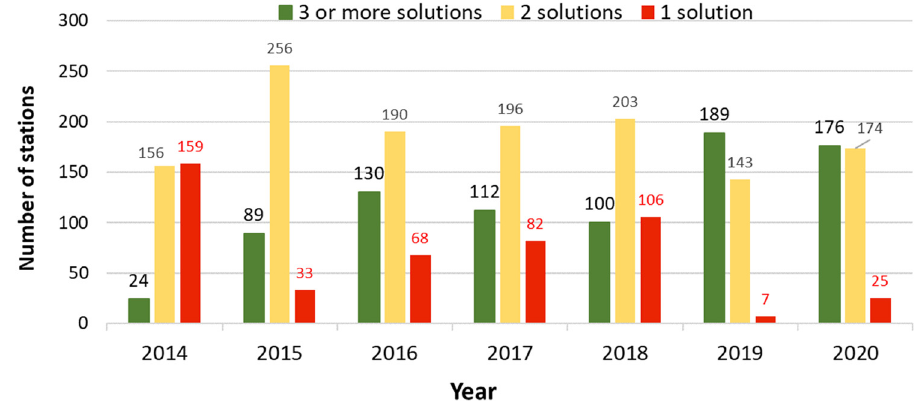
Figure 3: Number of stations with 1, 2, 3 or more solutions of tropospheric parameters before